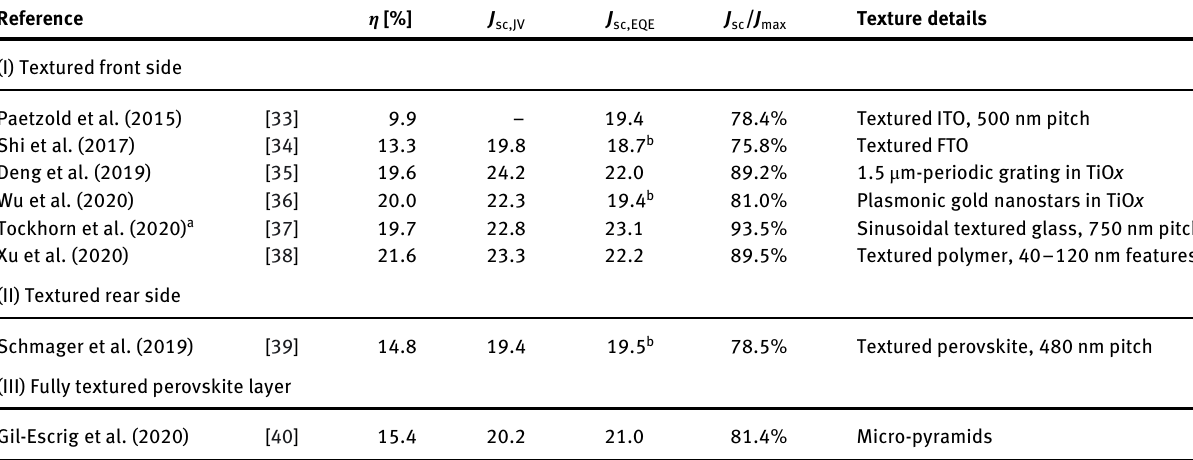
Table 2: Summary of recent perovskite single-junction solar cells with nano- or micro-textured absorber layers for light management. J sc , JV and J sc , EQE denote the short circuit current density ( J sc ) as determined from JV -characteristics and EQE, respectively. J sc , EQE ∕ J max denotes the ratio of J sc , EQE to themaximumattainable short circuit currentdensity ( J max ) accordingto therespectiveperovskite bandgap(theapproximate optically active bandgap of the perovskite was determined from the minimum in the derivative of the EQE [32], which where digitized from the respective publication). All J sc values are given in mA/ cm 2 .